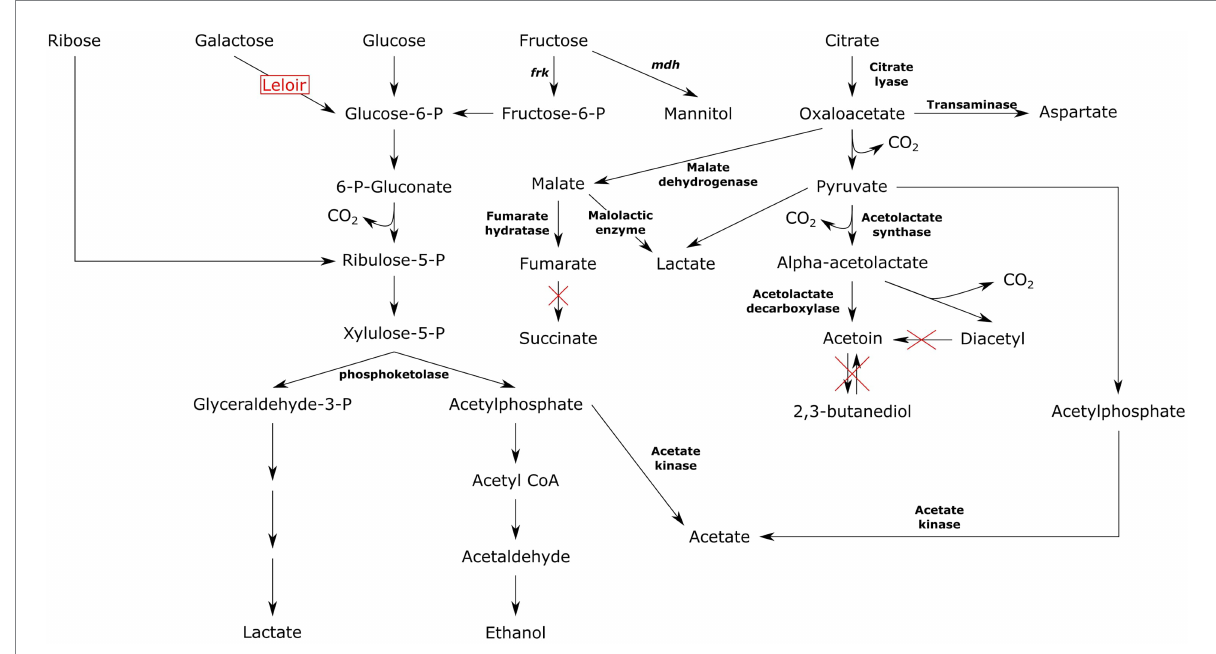
FIGURE 7 Putative carbohydrate and citrate metabolism pathway of Ln.